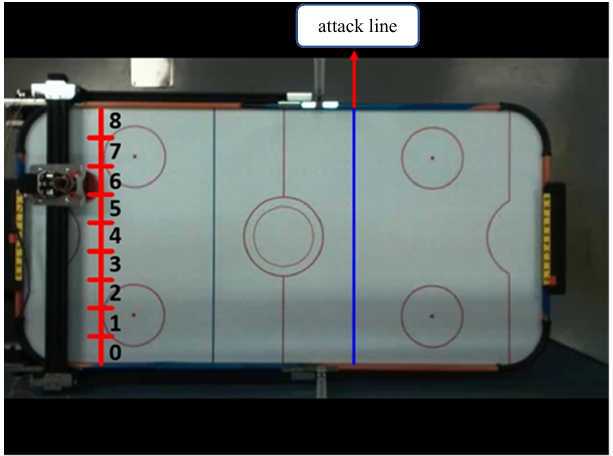
Figure 3. Schematic diagram of defense area of system implementation method 1.